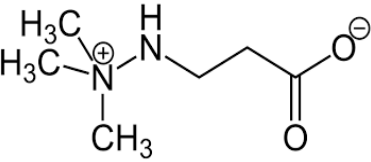
Figure 25. Chemical structure of meldonium. Formula: C 6 H 14 N 2 O 2.